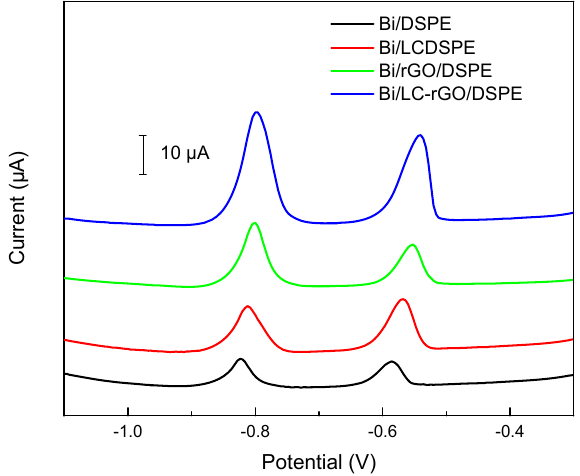
Figure 5. Differential pulse voltammetry of 30.0 μ g/L of Cd(II) and Pb(II) by different electrodes: the Bi/DSPE, Bi/LC/DSPE, Bi/rGO/DSPE and Bi/LC ‐ rGO/DSPE (deposition time: 240 s; deposition potential: − 1.2 V; supporting electrolyte: 0.1 mol/L pH 4.5 acetate buffer solution; Bi(III) concentration: 2 mg/L).